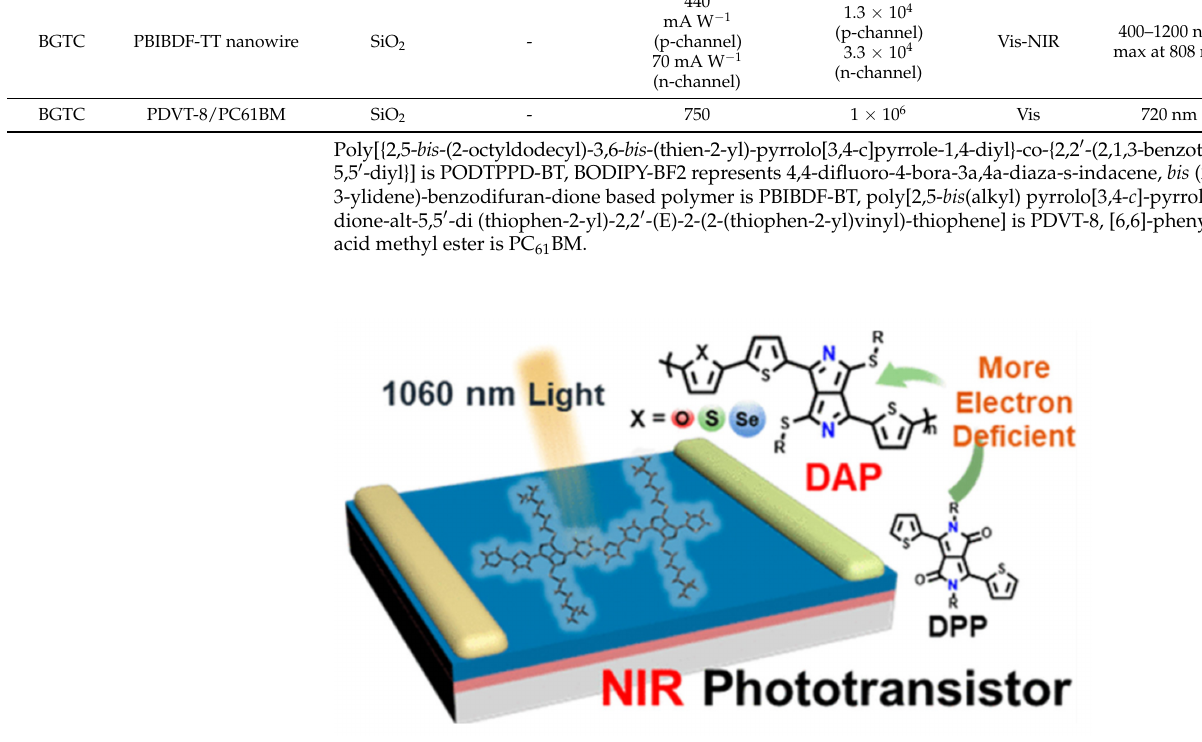
Figure 15. Design of BGTC OPT device and the chemical structure of the active material. Reprinted with permission from ref. [130]. Copyright 2021 American Chemical